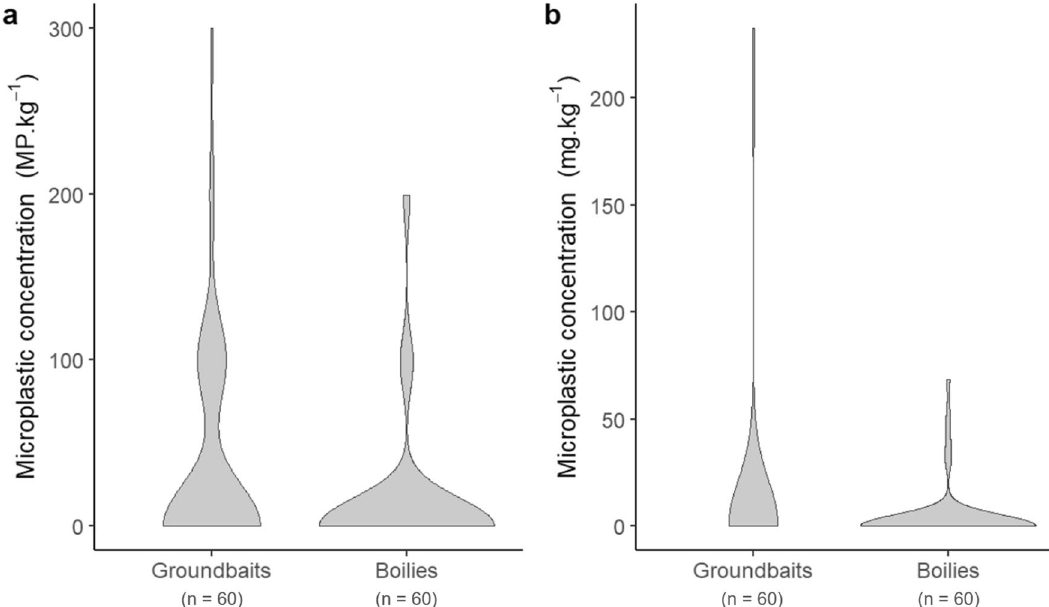
Figure 2. Microplastic concentrations in angling baits in ( a ) number (MP kg −1 ) and ( b ) mass (mg kg −1